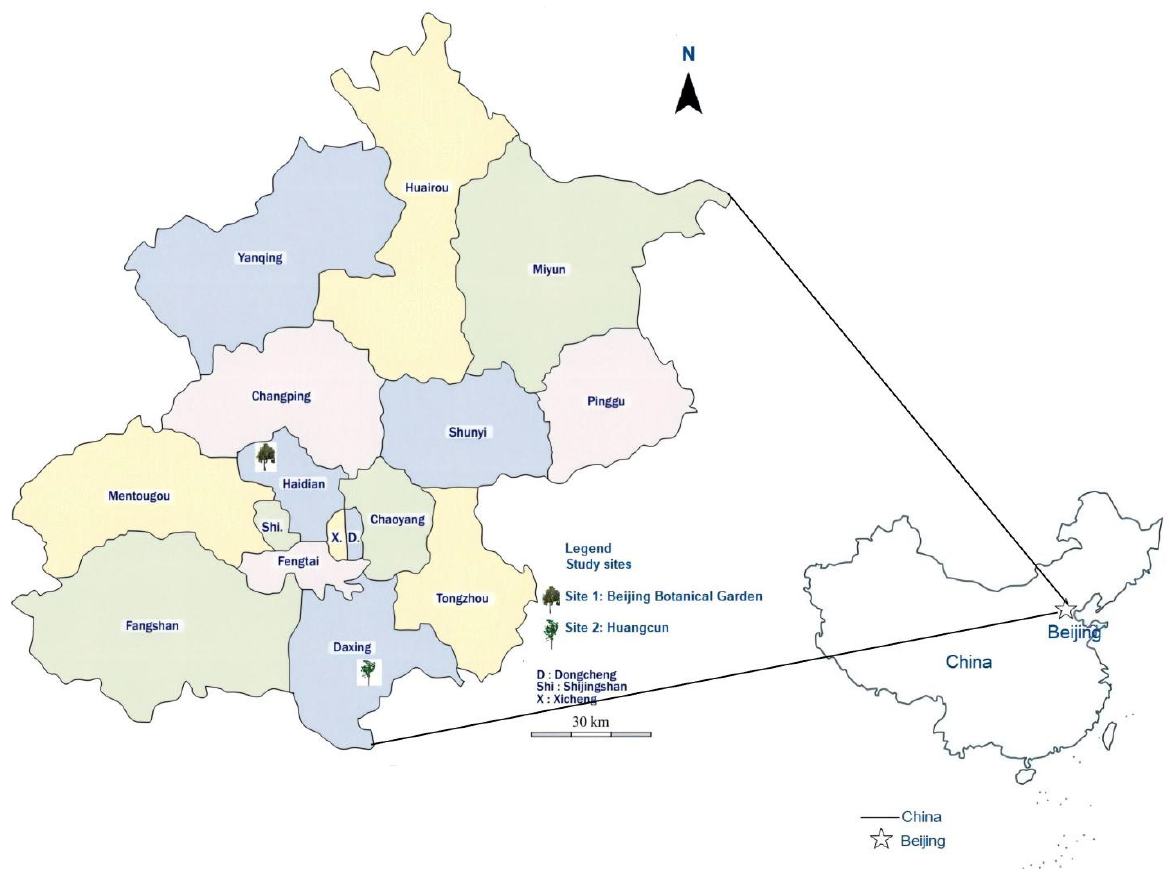
Figure 1. Location of the study sites.